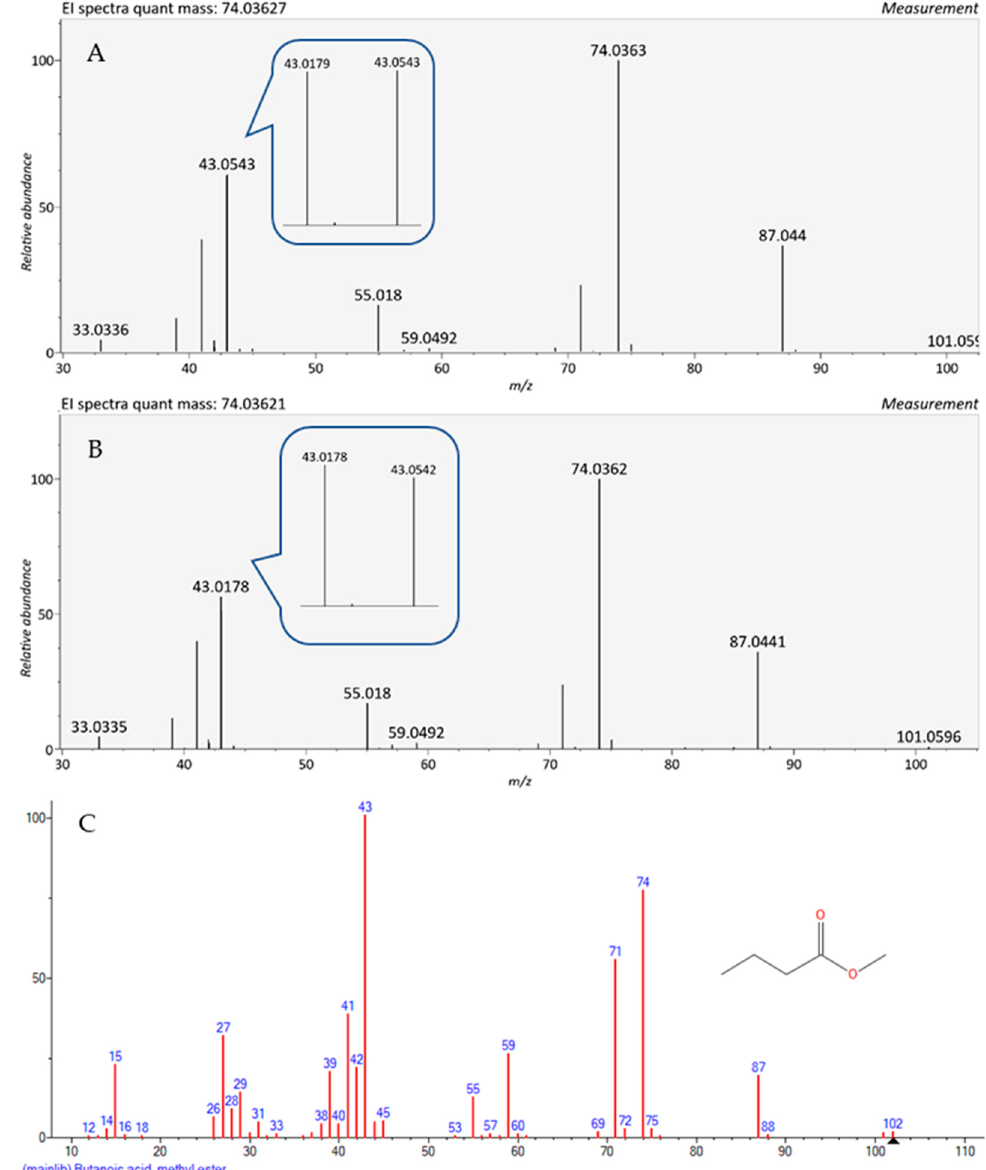
Figure 3. Methyl butyrate spectra using TD-GC-MS (Orbtriap) at two different concentrations: 0.3 nL/L and 1 nL/L. ( A ) At 0.3 nL/L the dominant ion has m / z 74.036 and the second ion has m / z 43.054; ( B ) At 1 nL/L the dominant ion has m / z 74.036, while the second ion has m / z 43.018; ( C ) NIST library for the same compound, where the dominant ion is 43 and the second is 74.